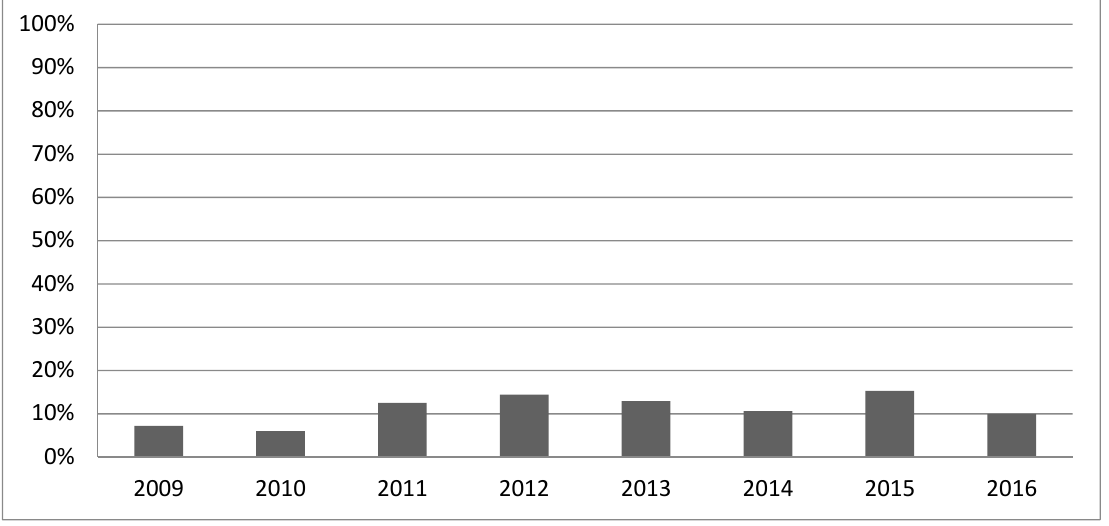
Figure 1. ROTEM application 2009–2016.